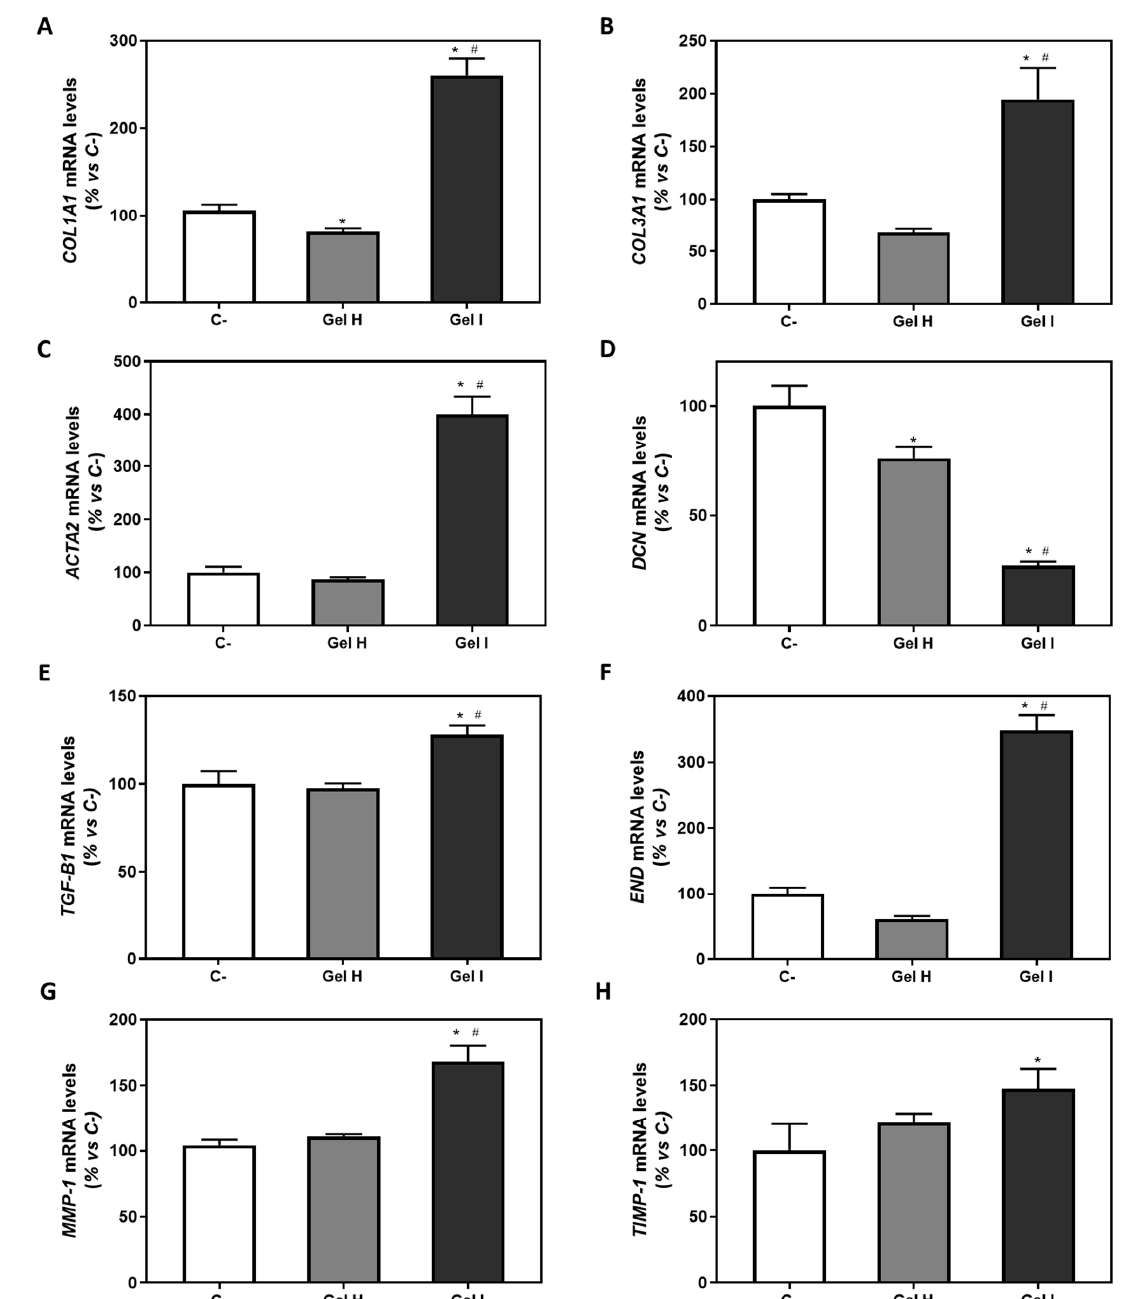
Figure 6. Gene expression levels of marker genes after treatment with periodontal gels. Effect of treatment with (Gel H) and (Gel I) for 48 h on mRNA expression levels of COL1A1 ( A ), COL3A1 ( B ), ACTA2 ( C ), DCN ( D ), TGF- β 1 ( E ), END ( F ), MMP-1 ( G ) and TIMP-1 ( H ) in iHGF, in the presence of LPS. Negative control (C − ) was obtained from cells seeded on plastic without treatment. See Table 1 for the identification of gels used in the study. Results are expressed as % vs. Negative control that was set to 100%. Values represent the mean ± SEM ( n = 6). Results were statistically compared by Kruskal-Wallis for Col1A1 and ACTA2; and by ANOVA and LSD as post hoc for Col3A1, TGF- β 1, END, DCN, MMP-1 and TIMP-1: * p < 0.05 treatment vs. control, # p < 0.05 Gel I vs. Gel